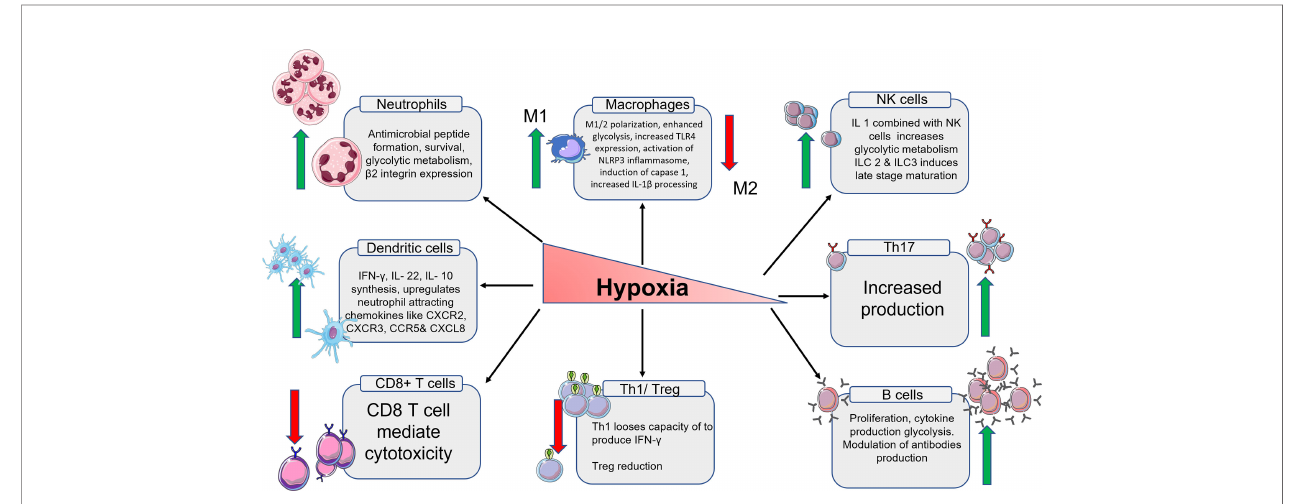
FIGURE 2 | Schematic representation of the immune cells and their products in hypoxia condition. From left, the expression of neutrophiles cells multiplies. The expression of M1 macrophages increases and M2 macrophages decreases. The total number of NK cells goes up which in turn increases the glycolytic metabolism. The number of Th17 cells goes up. B cells also increases along with high regulation of antibodies. Th1 cells and T reg cells production decreases due to low oxygen. The number T cytotoxic cells also decrease because of reduced oxygen. The number of DCs increases which intern increases the production of chemokines associated with